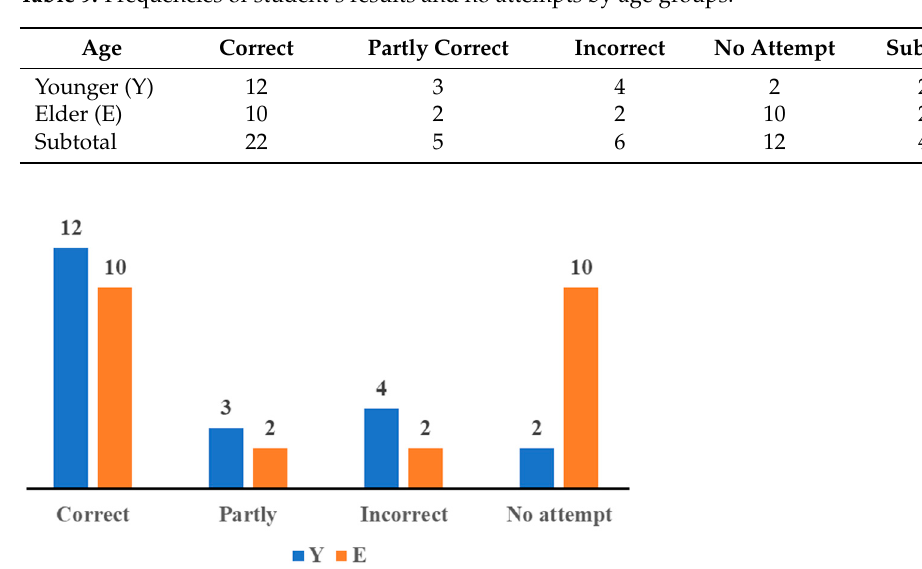
Table 9. Frequencies of student’s results and no attempts by age groups.